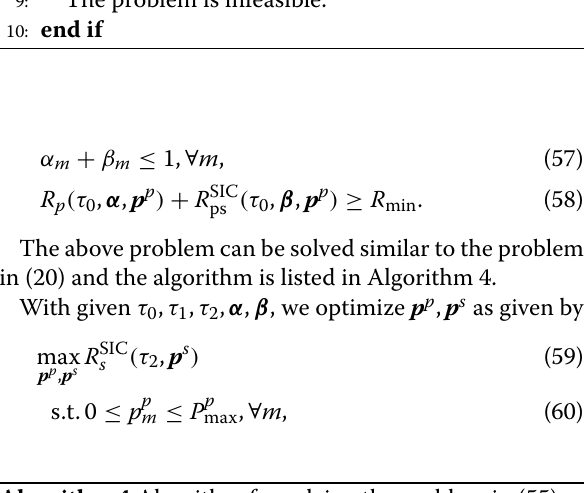
Algorithm 4 Algorithm for solving the problem in